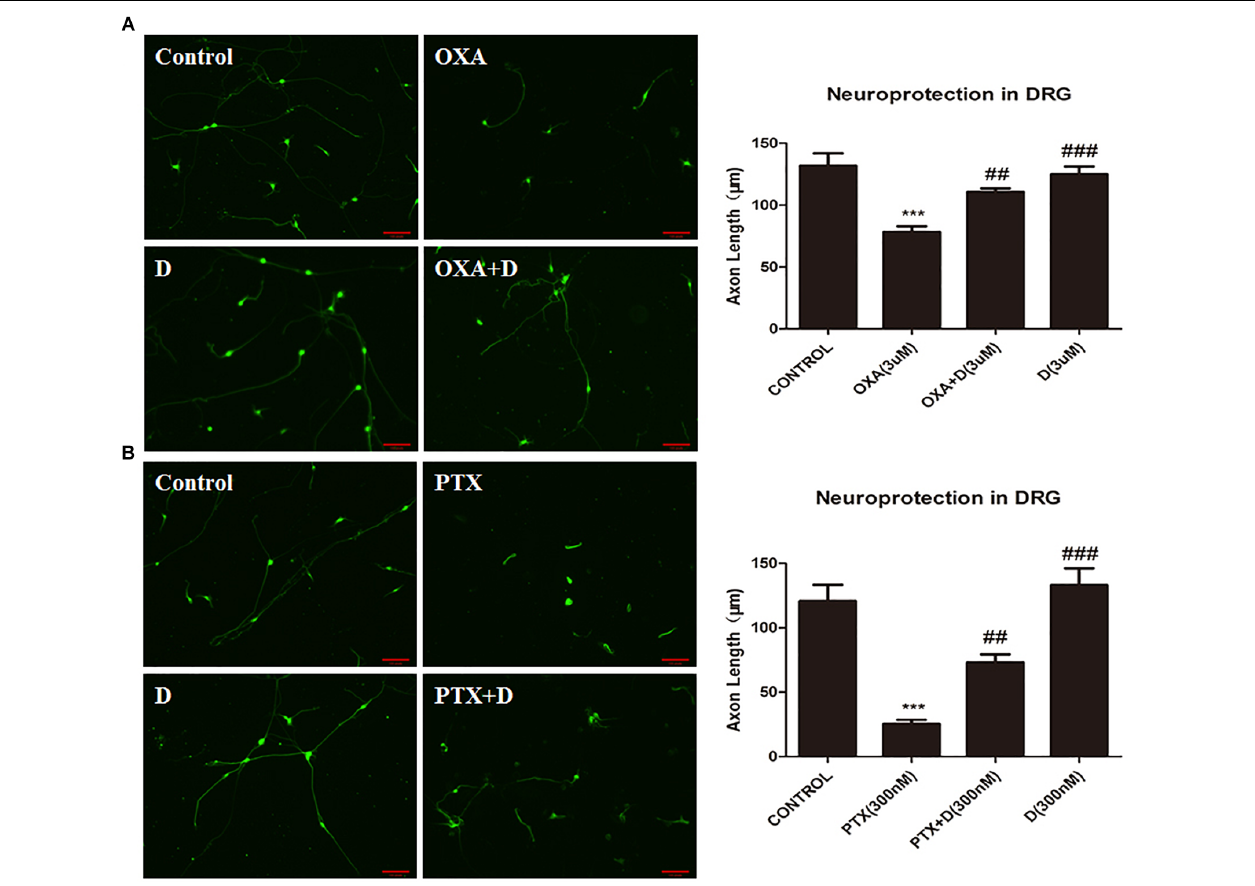
FIGURE 1 | Effect of duloxetine on axonal injury caused by oxaliplatin or paclitaxel (A) Primary rat DRG neurons were grown and axons were extended for 24 h. Neurons were then treated with OXA (3 µ M) or duloxetine (3 µ M) for 48 h. Cells were then subjected to immunofluorescence staining, and axon length measurements were performed ( ∗∗∗ p < 0.001 vs. control; ## p < 0.01; ### p < 0.001 vs. oxaliplatin alone). (B) Primary rat DRG neuronal cells were grown and axons were extended for 24 h. Neurons were then treated with PTX (300 nM) or duloxetine (300 nM) for 24 h. Cells were then subjected to immunofluorescence staining, and axon length measurements were performed ( ∗∗∗ p < 0.001 vs. control; ## p < 0.01; ### p < 0.001 vs. paclitaxel alone). The results are expressed as the mean ± SEM ( n =